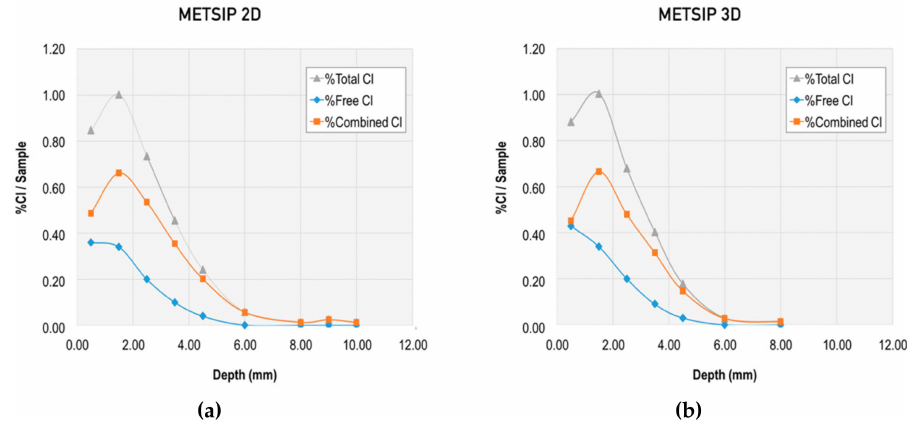
Figure 9. Total, free, and combined chloride content in METSIP mix at early ages: ( a ) at two days and ( b ) at three days.